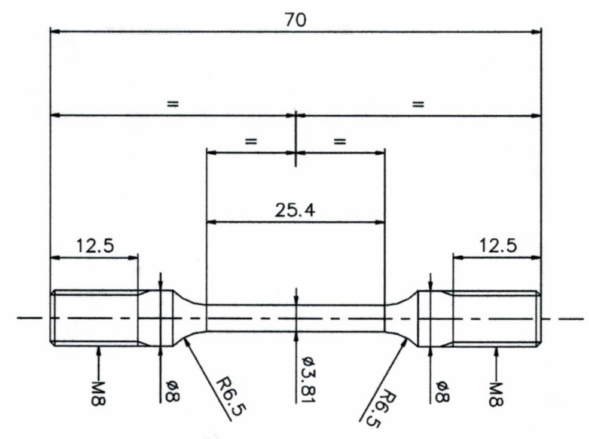
Figure 2. Dimensions of the slow strain rate testing (SSRT) test specimen (Unit: